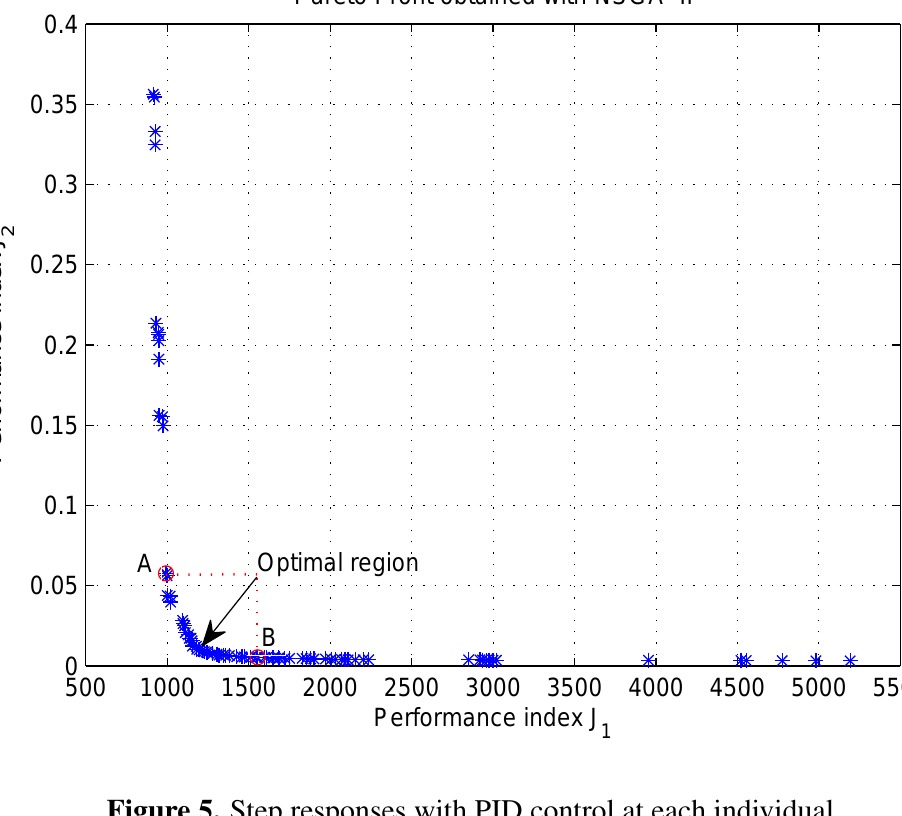
Figure 4. Pareto Front of performance index J